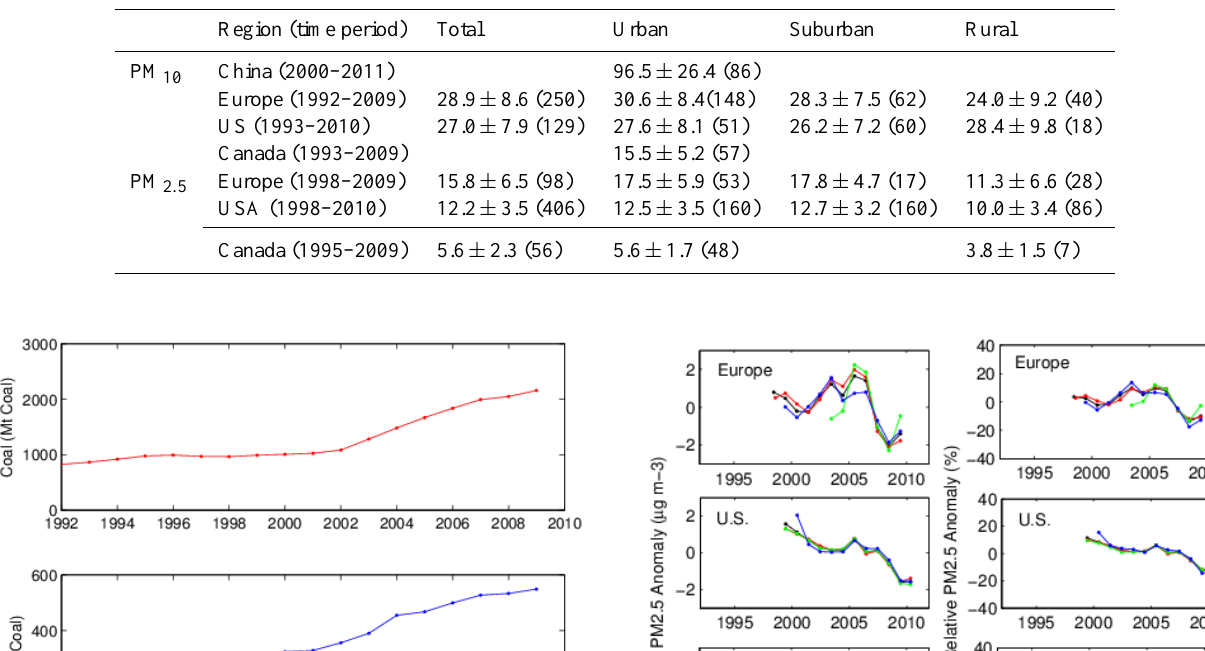
Table 1. Multi-year regional averages of PM 10 and PM 2 . 5 (unit: µgm − 3 ) with a standard deviation in the study regions. The averages of all the available data are shown in the third column (Total). The numbers in the brackets of the last four columns show the number of the stations where data are available for the averages. Values for each site can be found at Fig. 2.